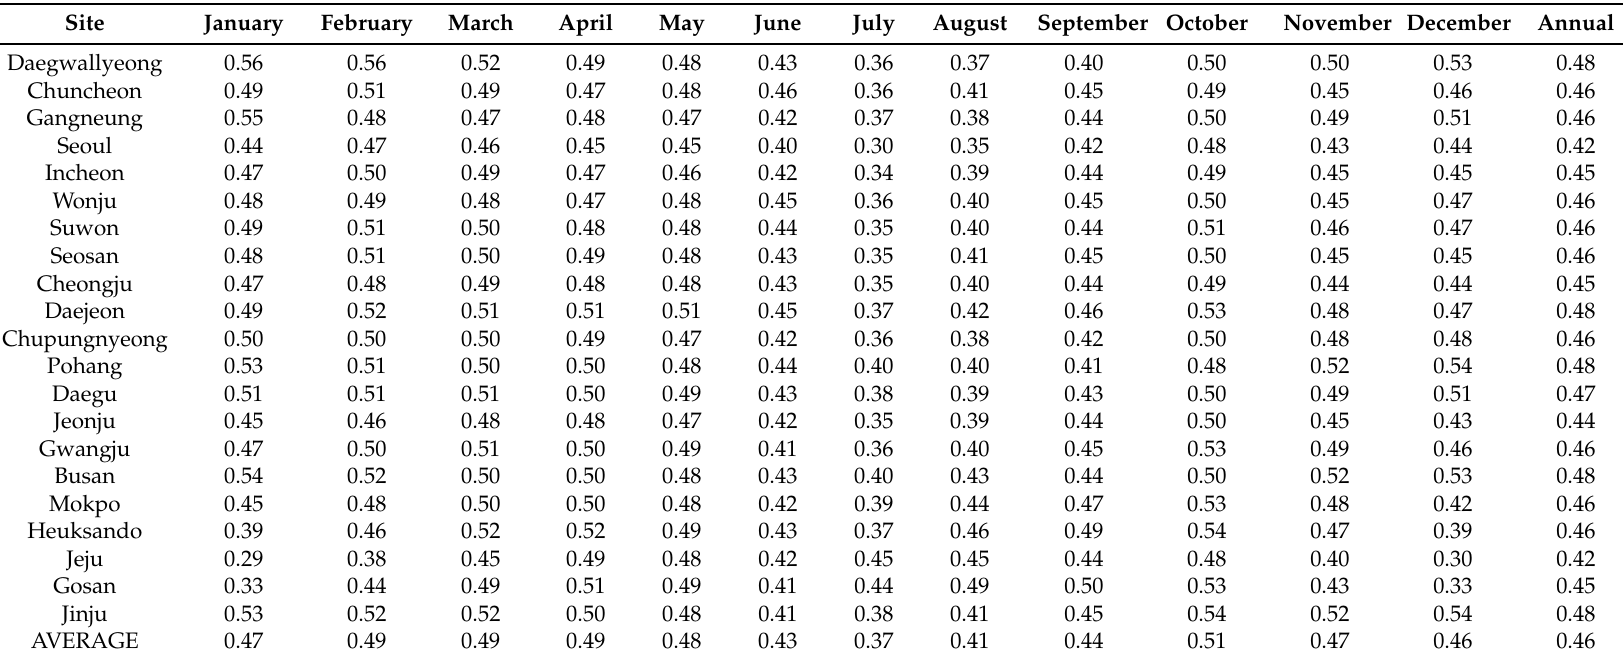
Table 1. Monthly climatology of K T under all-sky conditions at the 21 measurement